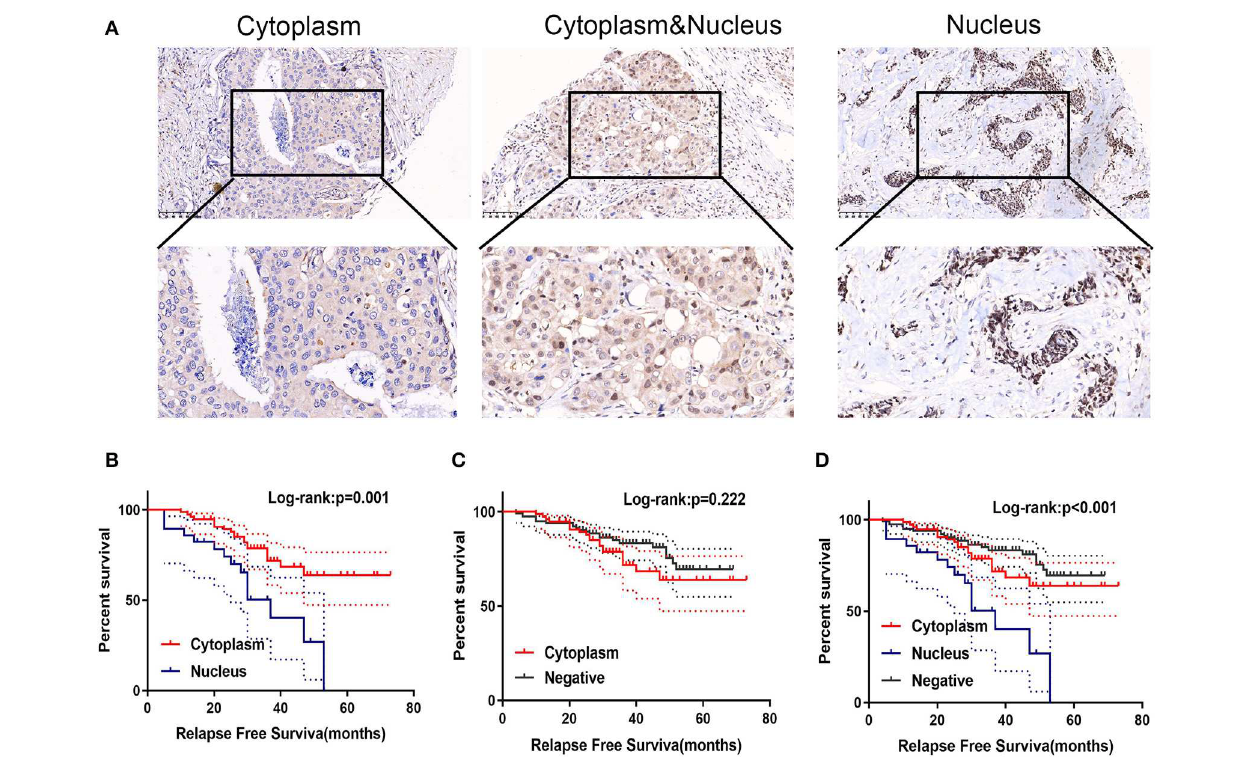
FIGURE 2 | Positive of GPSM2 nucleus expression is significantly related with worse prognosis. (A) GPSM2 staining in different subcellular regions. (B) Kaplan-Meier survival analysis and log-rank test indicated that the GPSM2-nucleus patients presented with a shorter RFS time than GPSM2-cytoplasm patients ( p = 0.001). (C) Kaplan-Meier survival analysis and log-rank test showed no significant difference between the RFS time of the GPSM2-cytoplasm group and GPSM2-negative group ( p = 0.22). (D) Kaplan-Meier survival analysis and log-rank test demonstrated RFS of patients in the GPSM2-nucleus group was significantly reduced compared with that in other patients ( p <